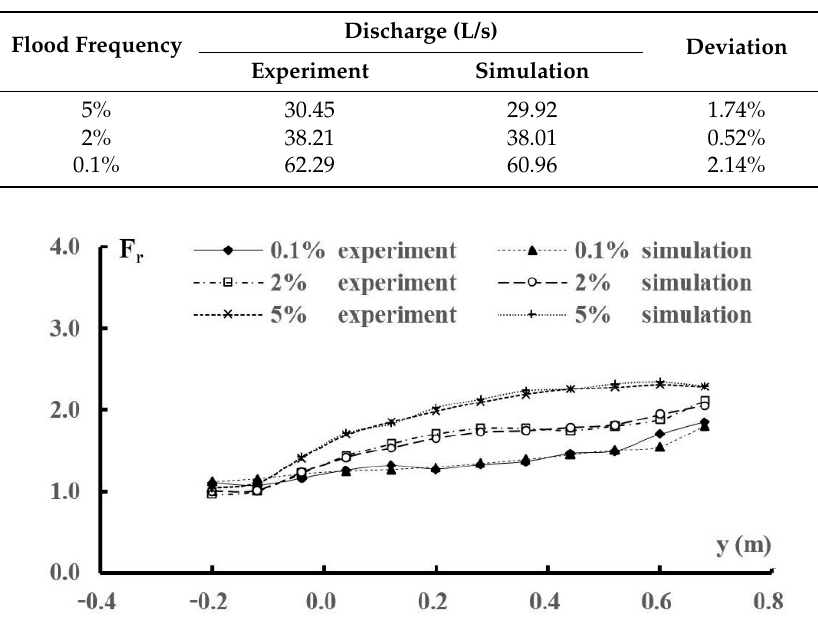
Figure 5. Froude number profile in intake tunnel.